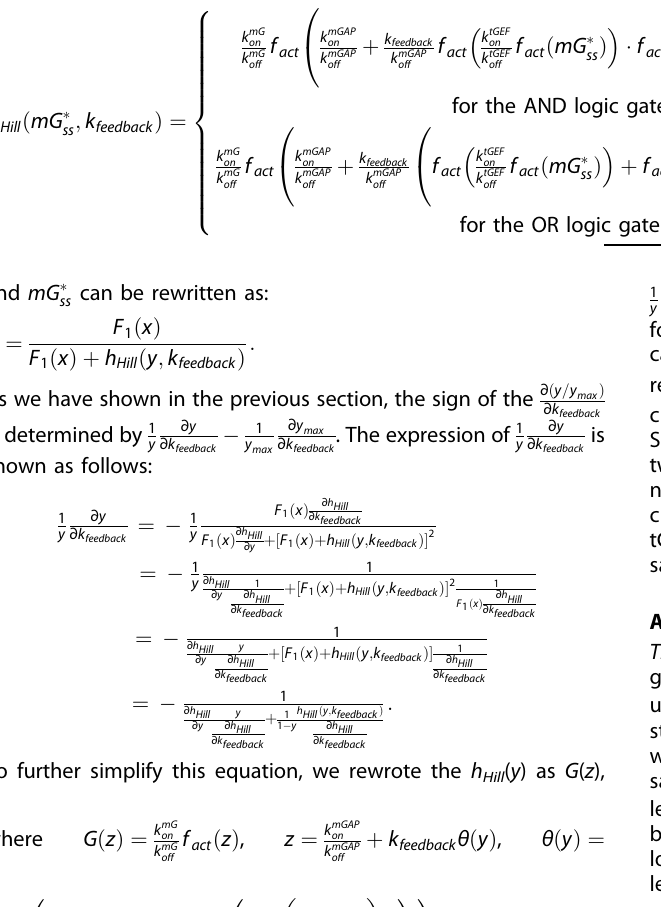
where h 1 ð mG (cid:1) Þ and h 2 ð mG (cid:1) Þ denote tGEF ss and tG (cid:1) ss ss All variables are steady-state values when the stimulus S → ∞ . Because the function k OR feedback k AND feedback